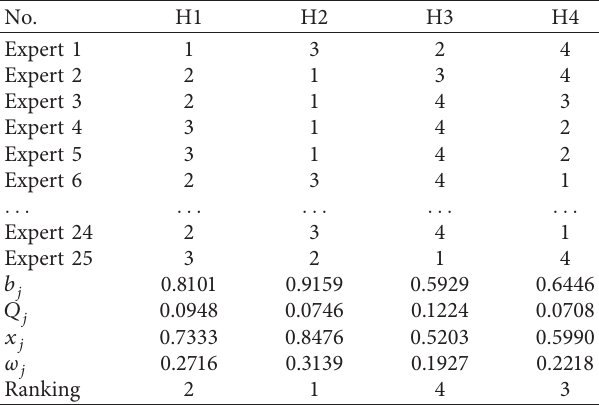
Table 5: The weights of 4 secondary indexes related to